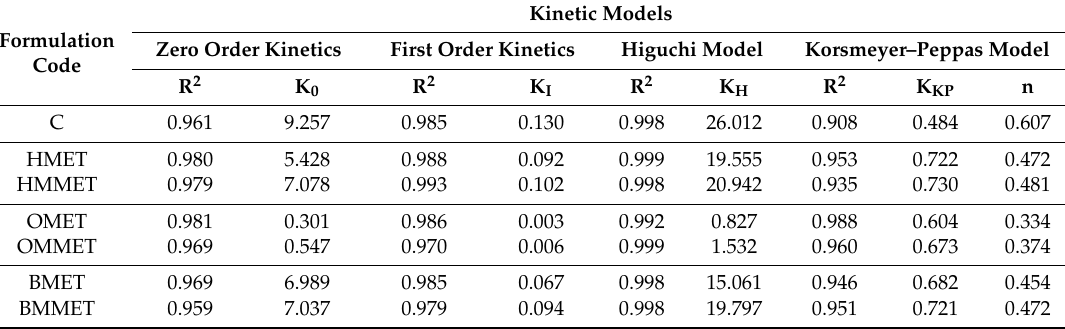
Table 5. Models of MET / MMET release from designed formulations and commercially available product (C).